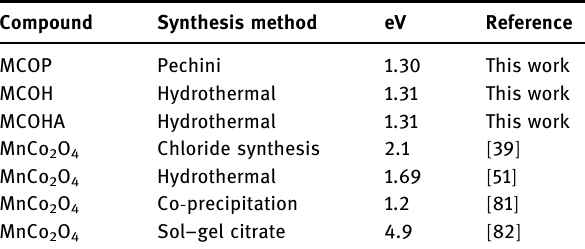
Table 3: Band gap comparison of the MCO synthetized in this work against the reported values in the literature